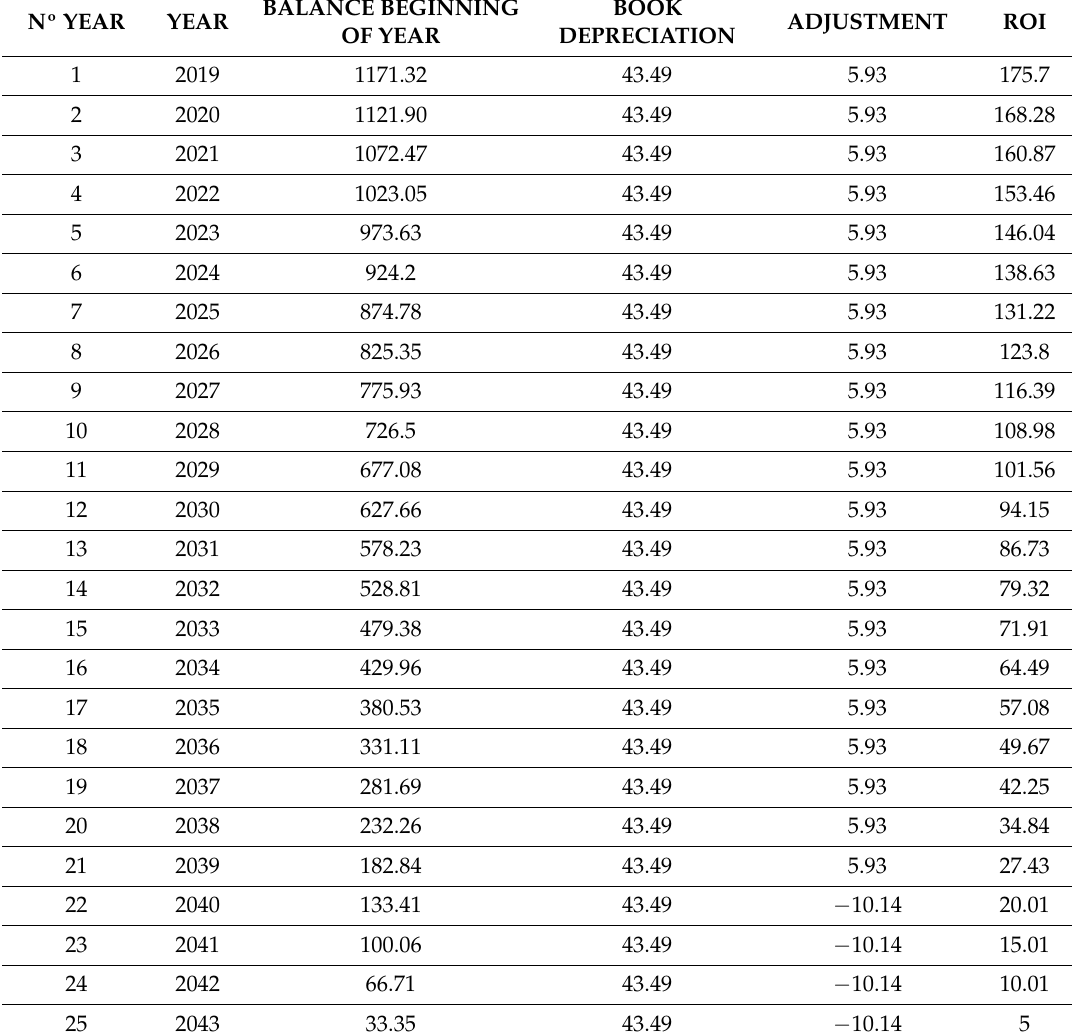
Table A5. Return of interests (ROI) on common equity (25%) (in millions of USD).